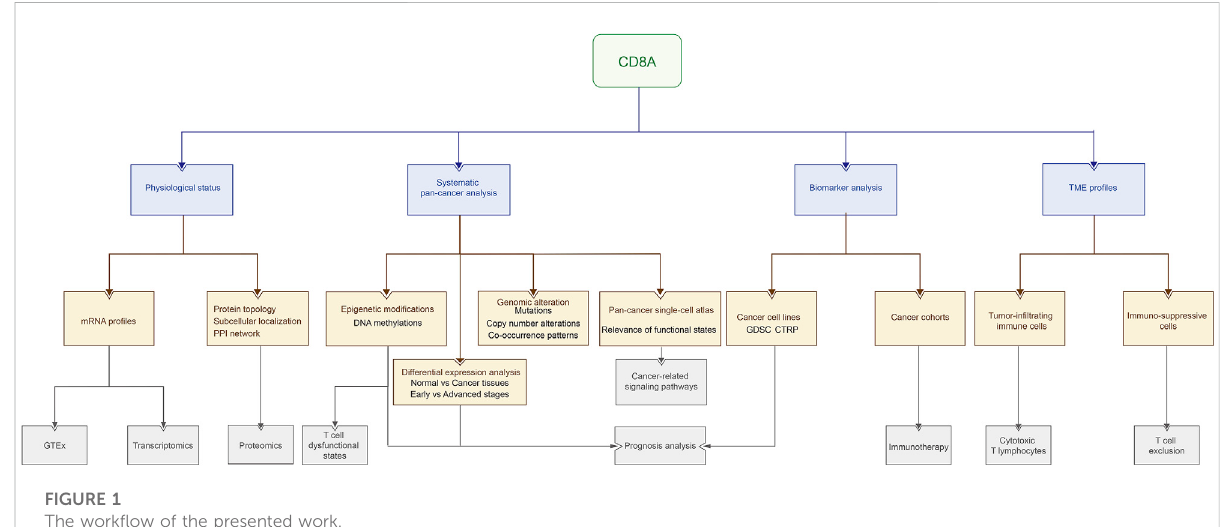
FIGURE 1 The work fl ow of the presented